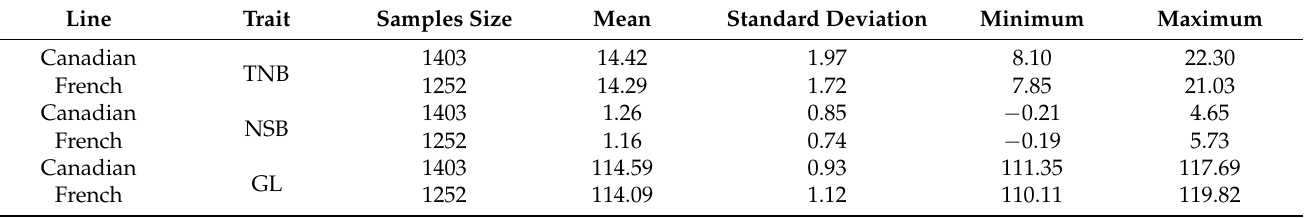
Table 1. Descriptive statistics for total number born (TNB), number of stillborn (NSB), and gestation length (GL) in the two lines of Large White